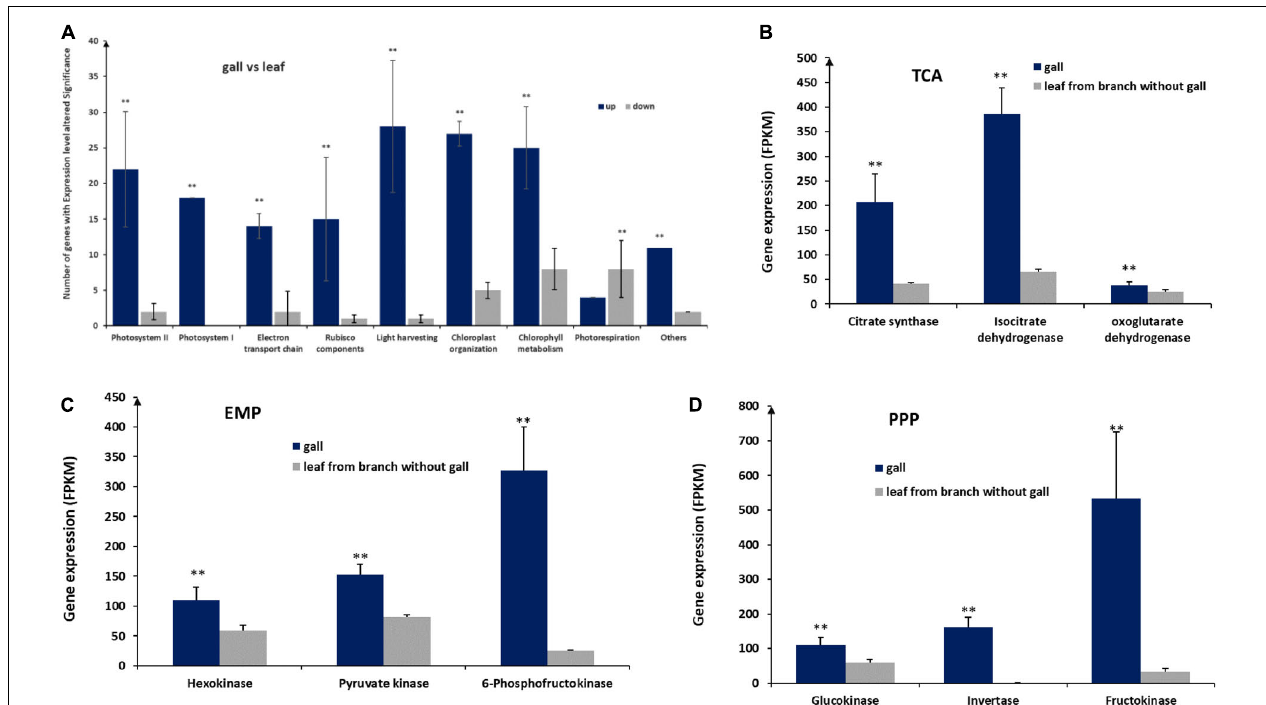
FIGURE 4 | Expression of genes involved in photosynthesis and glycometabolism. (A) Expression of genes in nine pathways associated with photosynthesis. (B) Expression of genes of the tricarboxylic acid (TCA) cycle, encoding citrate synthase, isocitrate dehydrogenase, and oxoglutarate dehydrogenase. (C) Expression of genes encoding hexokinase, pyruvate kinase, and 6-phosphofructokinase acting in the Embden–Meyerhof–Parnas pathway (EMP). (D) Expression of genes acting in the pentose photosphate pathway (PPP), encoding glucokinase, invertase, and fructokinase. ** represent significant difference, P <